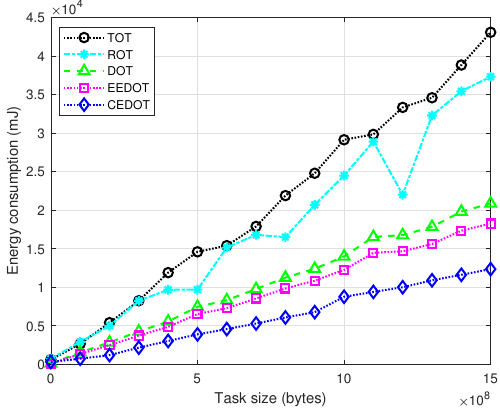
Figure 2. Energy consumption for different task sizes.